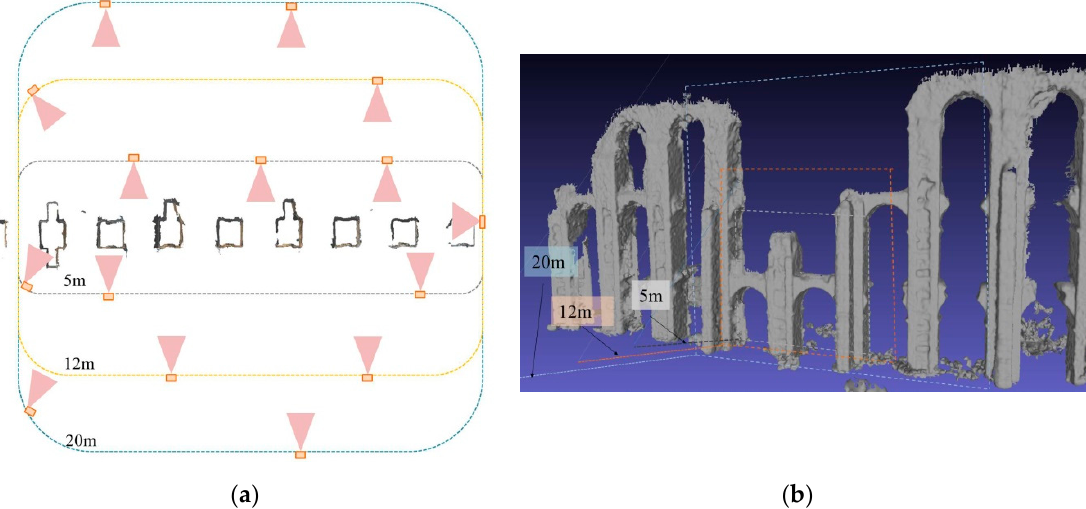
Figure 5. ( a ) Scheme with the data capture trajectories and ( b ) the areas covered by a frame, for 5, 12 and 20 m of distance prototype-monument. The figure that appears in ( b ), is a 3D model (mesh) generated by the software Meshlab [61] from the 20m points cloud made only for visualization purposes.